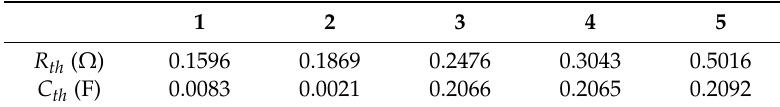
Table A2. A brief datasheet of TPH3006PS.